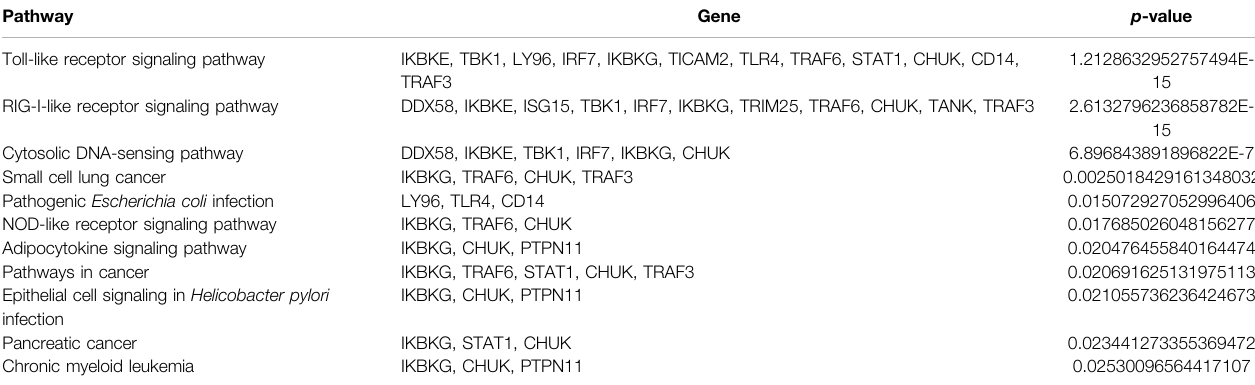
TABLE 3 | The pathway of module 2.